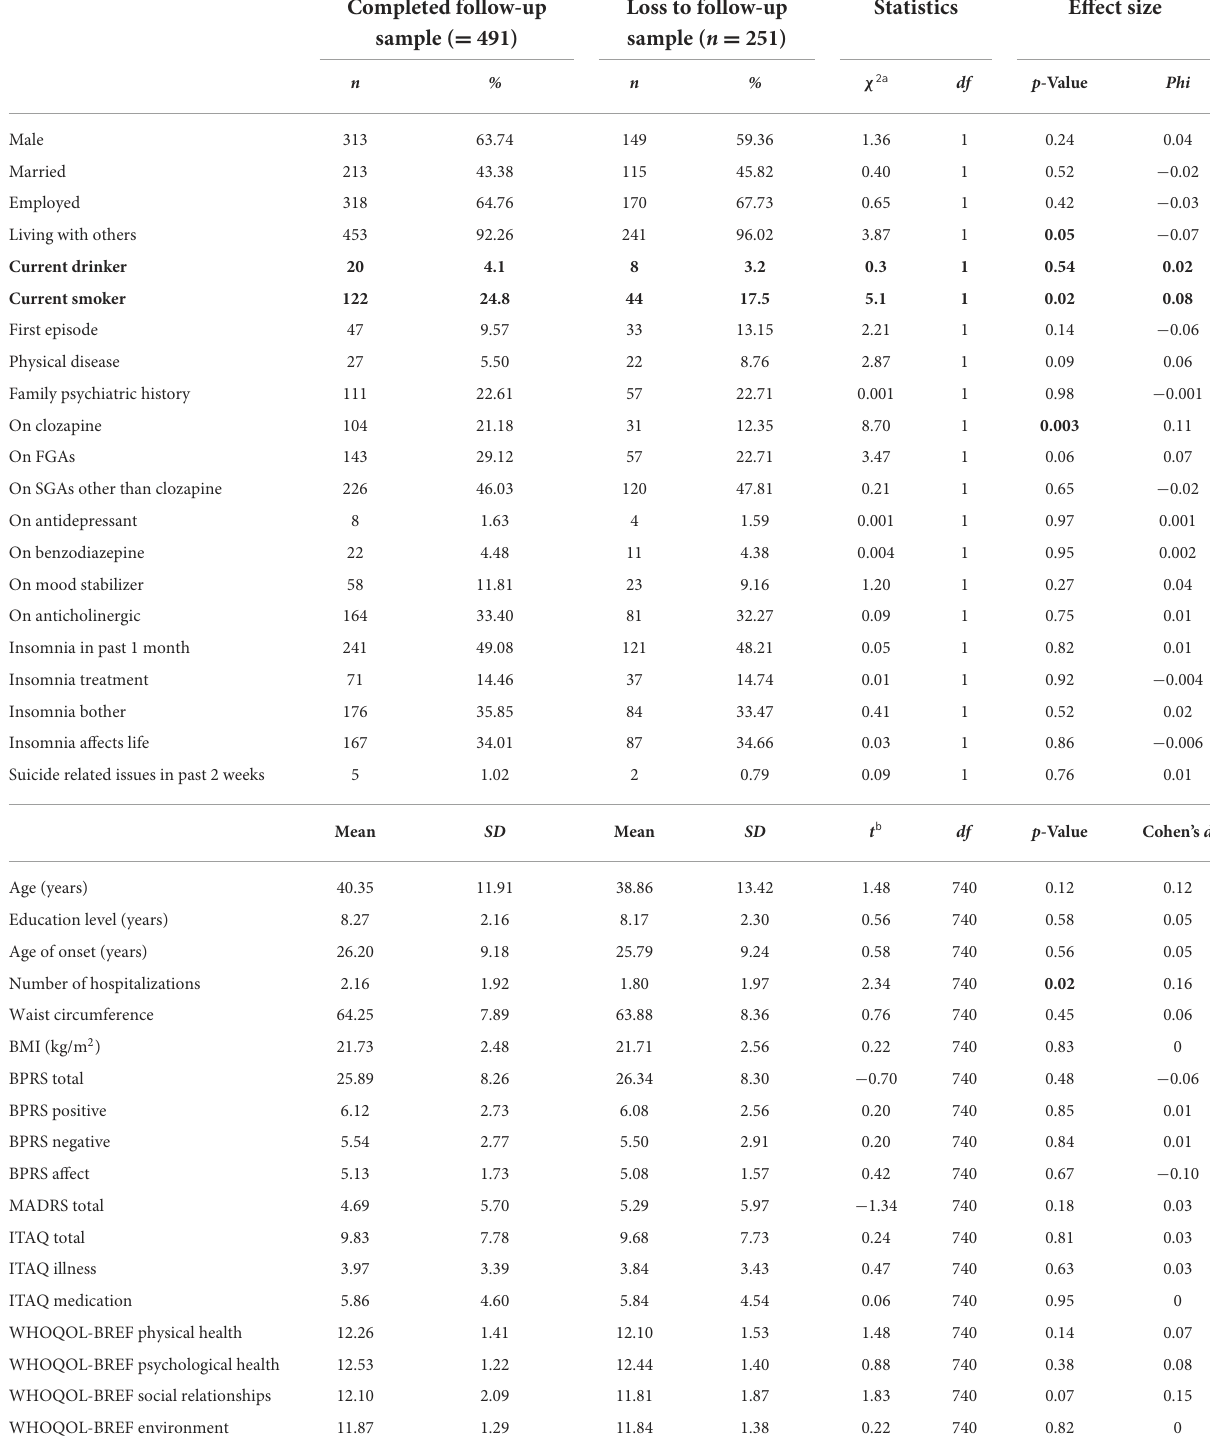
TABLE 1 Sociodemographic and clinical characteristics of the study sample. Completed follow-up Loss to follow-up